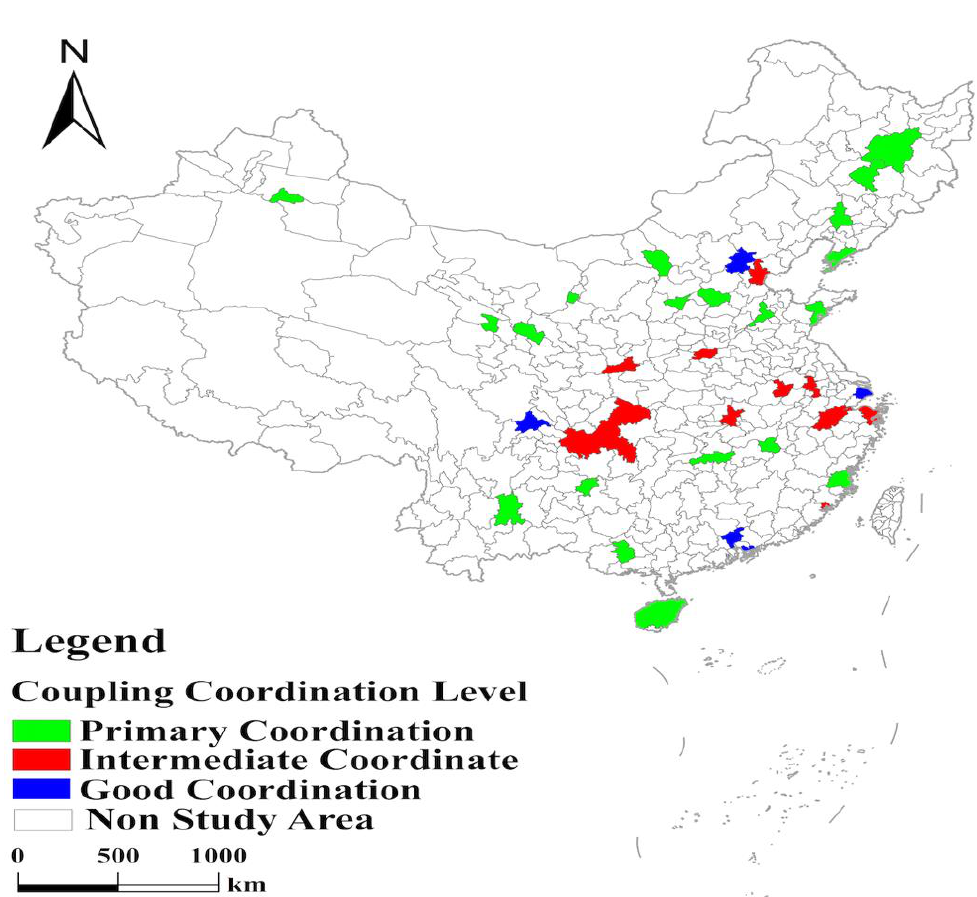
Figure 2. Spatial coupling coordination evaluation. Table 4. Results of coupling coordination evaluation.